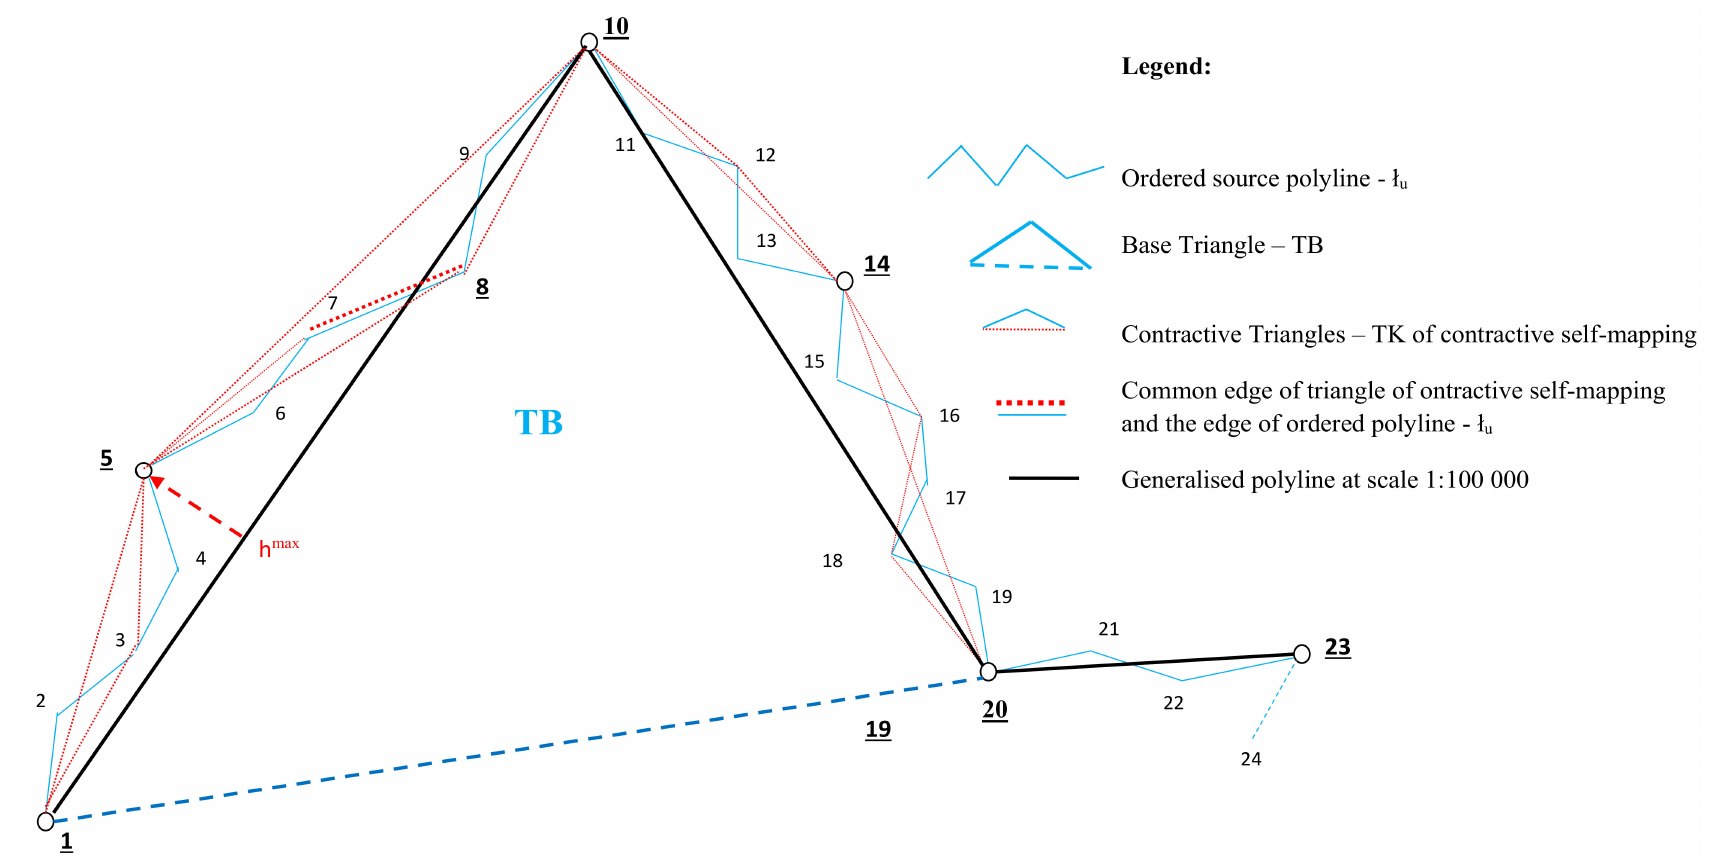
Figure A7. Generalisation of ordered polyline— l u to scale 1:100,000 (from the source scale 1:10,000) with contractive mapping of the triangles TK created in binary tree system and verification of dimensions of triangles in accordance with Couchy condition and minimum dimensions of Salishchev for: bases-p AS = 98.5 m, p min = 108.0 m ± 15.0 m → p AS < p min , heights-h AS = 31.5 m, h max = 17.0 m ± 9.0 m → h AS > h max